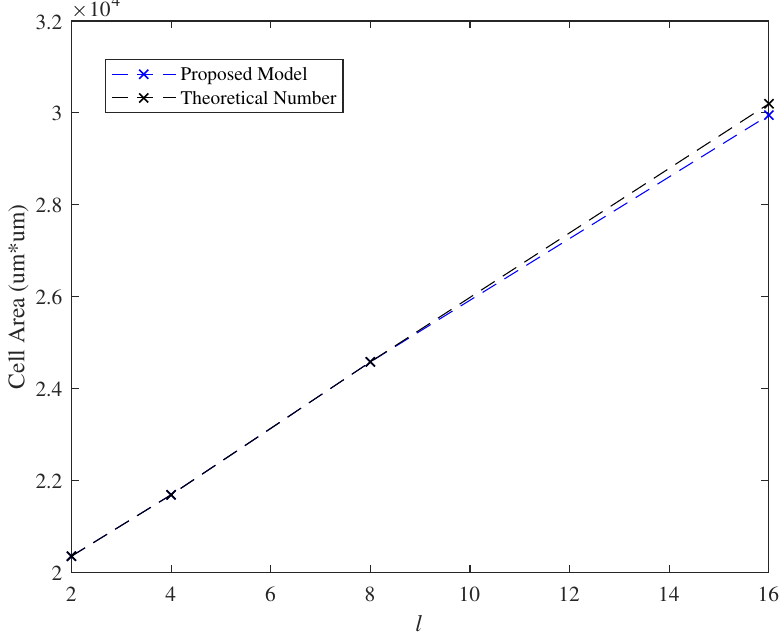
Figure 14. Effect of the parameter l with respect to the cell